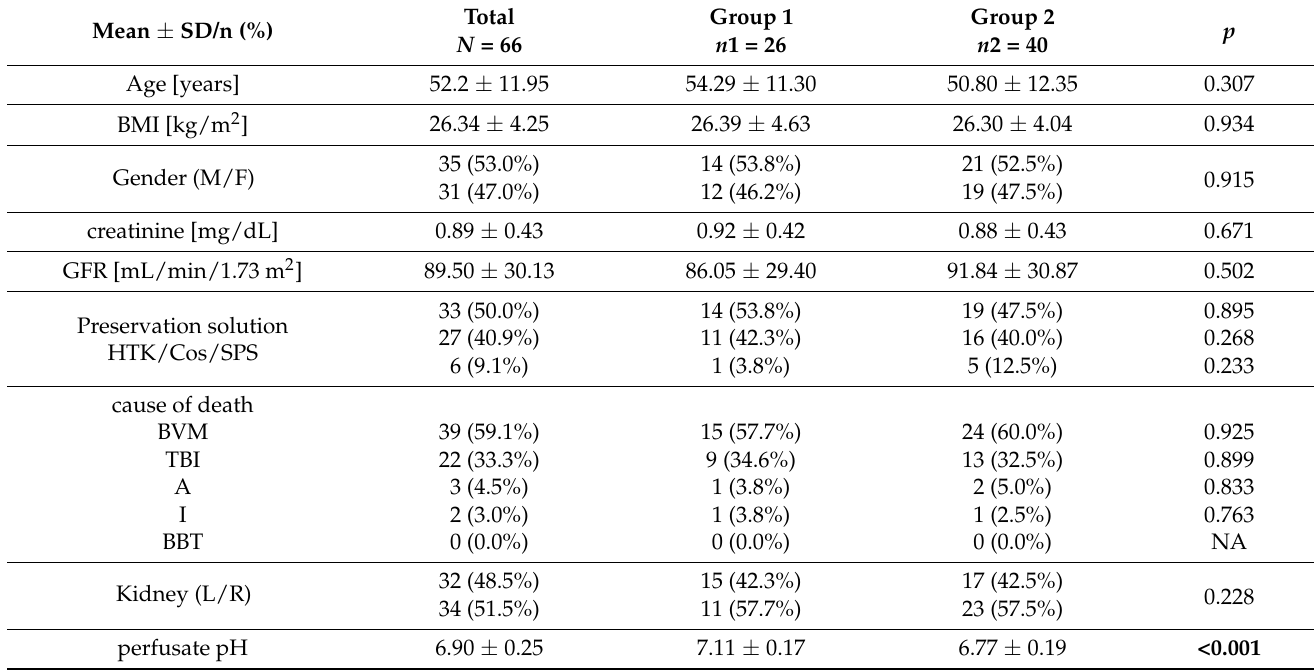
Table 3. Donor-related parameters in the study group qualified for organ